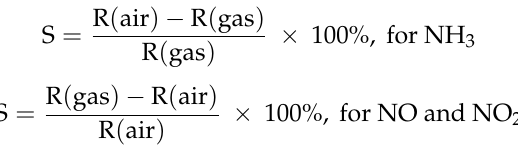
Table 3. Recent works comparing light-activated (with LED) NH 3 , NO, and NO 2 gas sensor per- formances at room temperature for different pure and composite materials. Sensor signals were recalculated